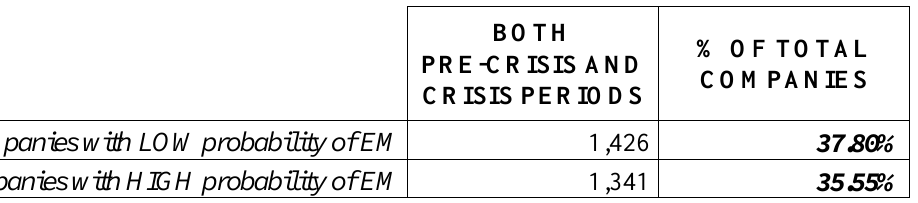
Table 3: Number of companies with the same probability (high or low) before and after